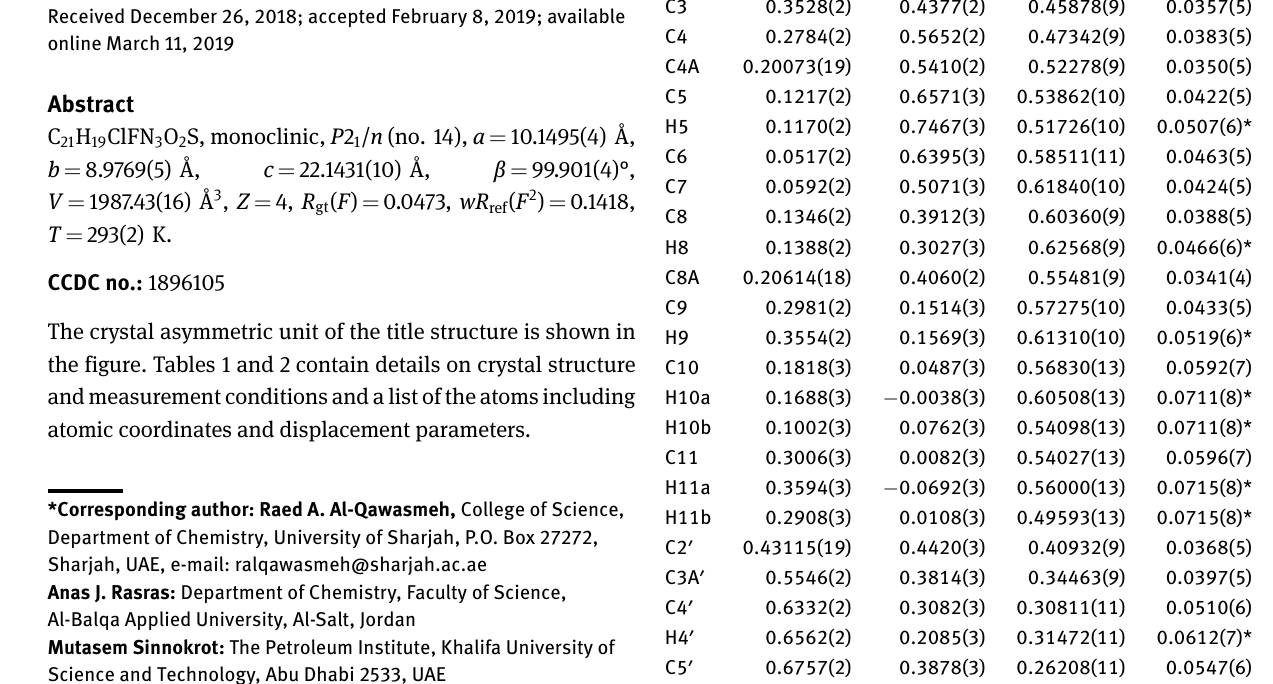
atomic coordinates and displacement parameters.